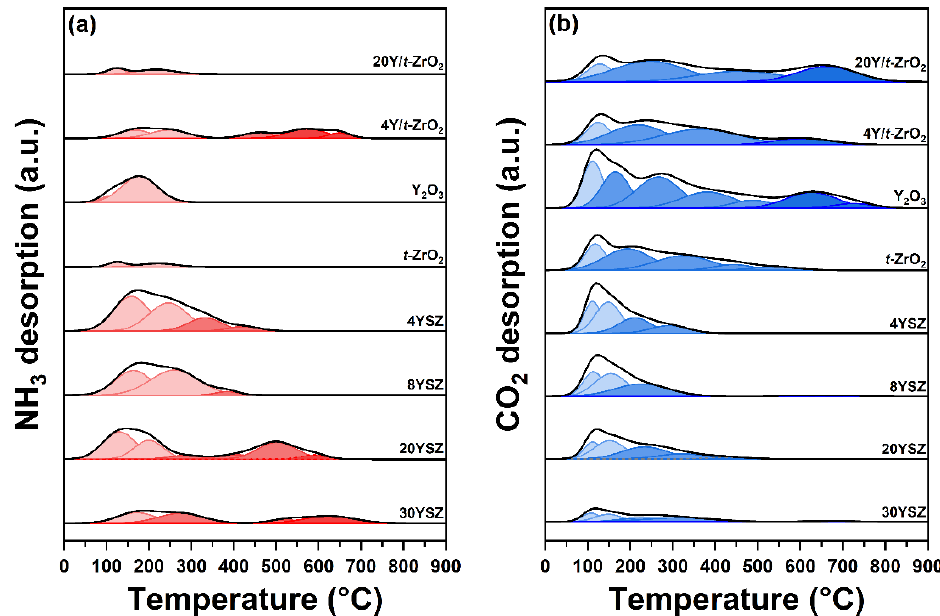
Figure 5. TPD profiles of ( a ) NH 3 and ( b ) CO 2 for the co-precipitated x YSZ ( x = 4, 8, 20, and 30) and impregnated x Y/ t -ZrO 2 ( x = 4 and 20) catalysts along with bare t -ZrO 2 . The deconvoluted peaks are distinguished by changing the intensity of red ( a ) and blue ( b ) colors from bright to dark with the desorption temperature increasing. Table 1. Density of acid and base sites for all of the tested catalysts.